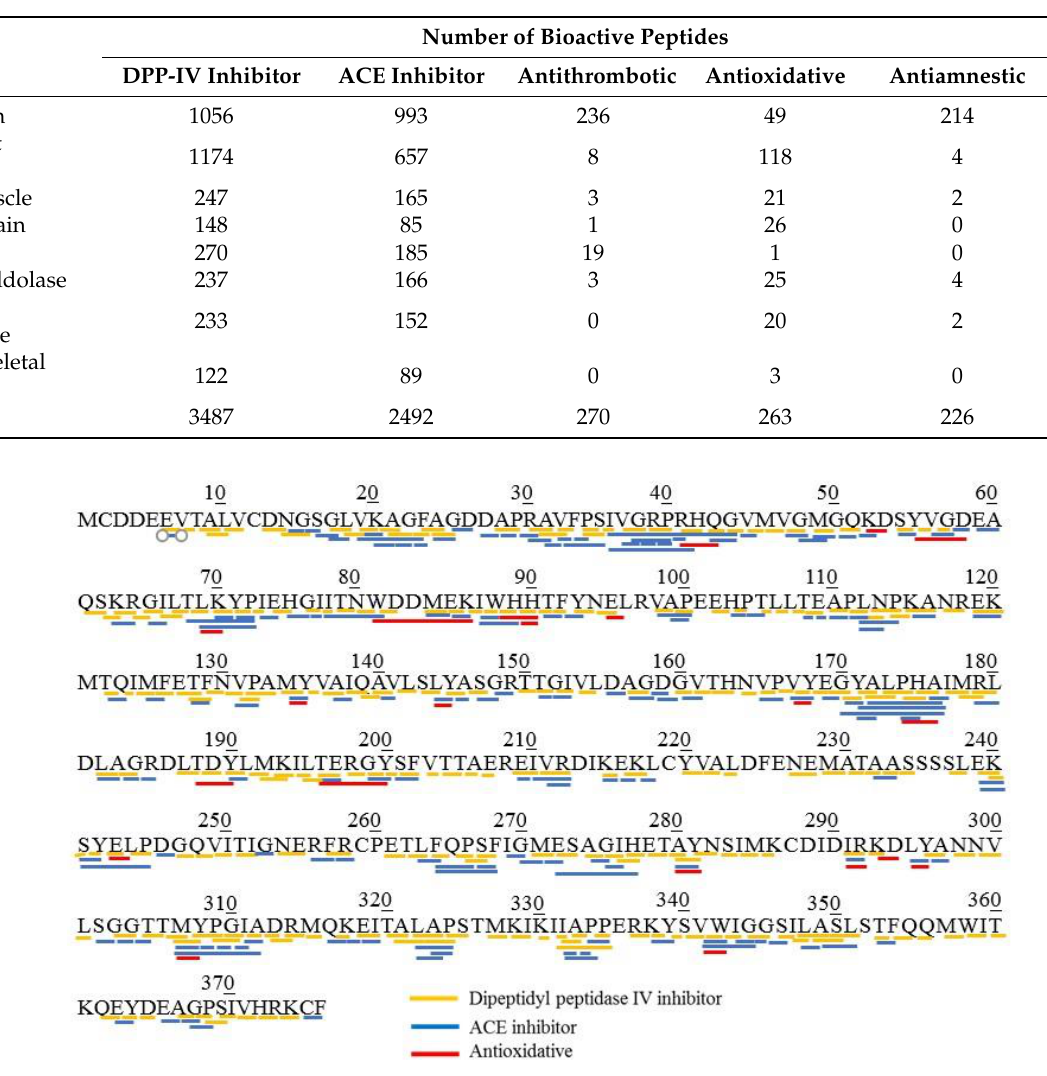
Figure 4. Potential bioactive peptides profiling of actin (SwissProt: P49055) identified from Mackerel Steaming Juice (MSJ).